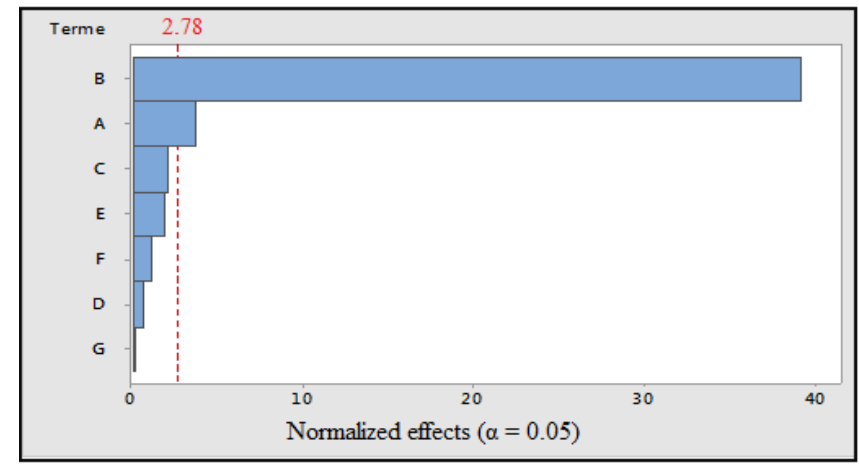
Figure 2. Pareto diagram of normalized effects (α = 0.05). A: cooking time; B: cooking temperature; C: volume of cooking water; D: concentration of solvent; E: maceration time; F: ultrasonic time; and G: grinding.